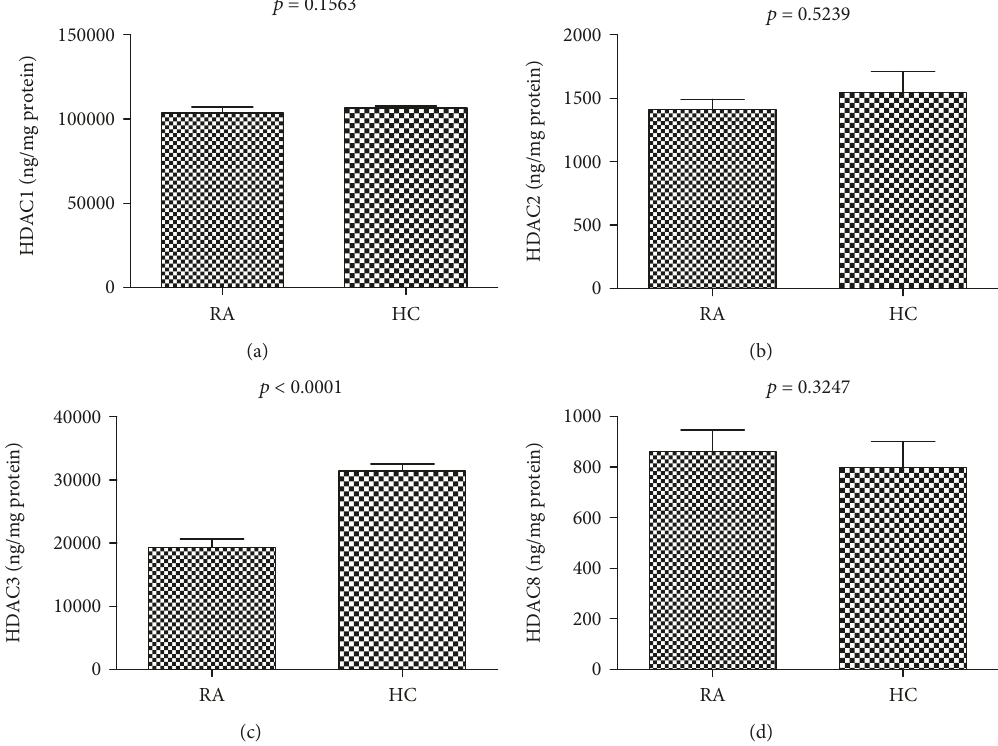
Figure 4: Individual class I HDACs activity in the nuclear extracts of PBMCs in RA patients and HCs. The HDAC3 activity level was signi fi cantly reduced in patients with RA compared to those of HC.